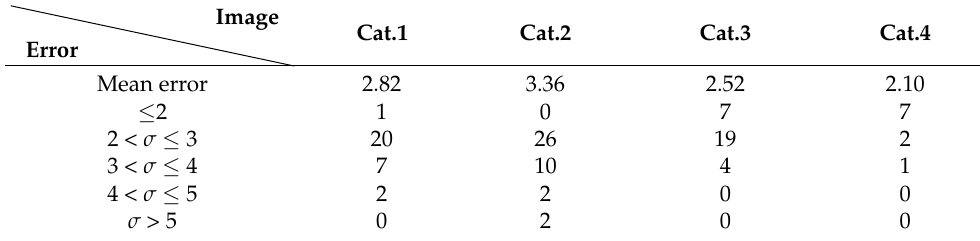
Table 5. Summary of image chip matching error after brightness calibration (unit: Pixel).